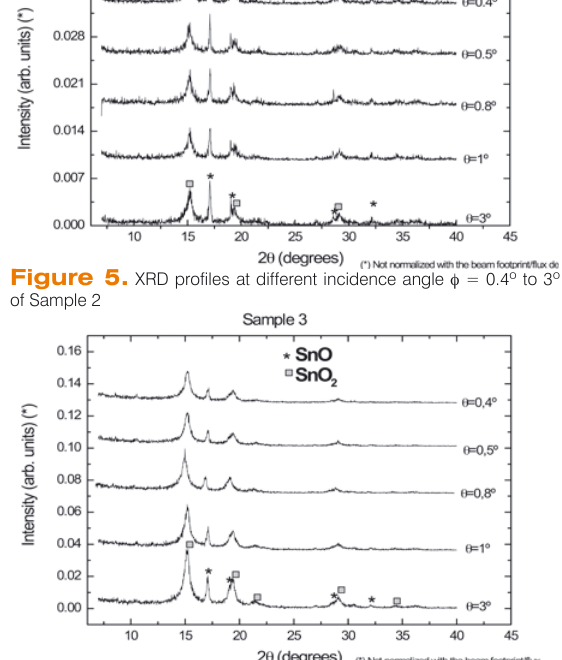
Figure 9. Sn 3d photoelectron peaks for: (a) Samples 2 or 3, (b) Sample